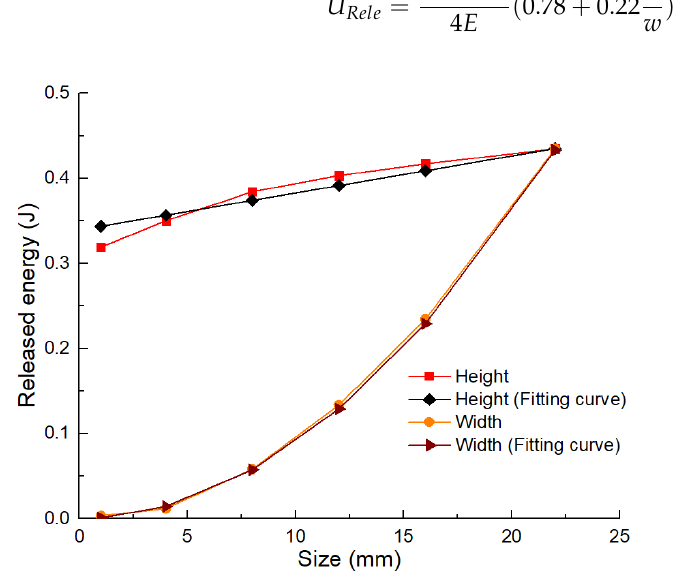
Figure 13. The fitting curve of Equation (9). If the width or height of 22 mm are maintained, then another size changes from 1 mm to 22 mm.